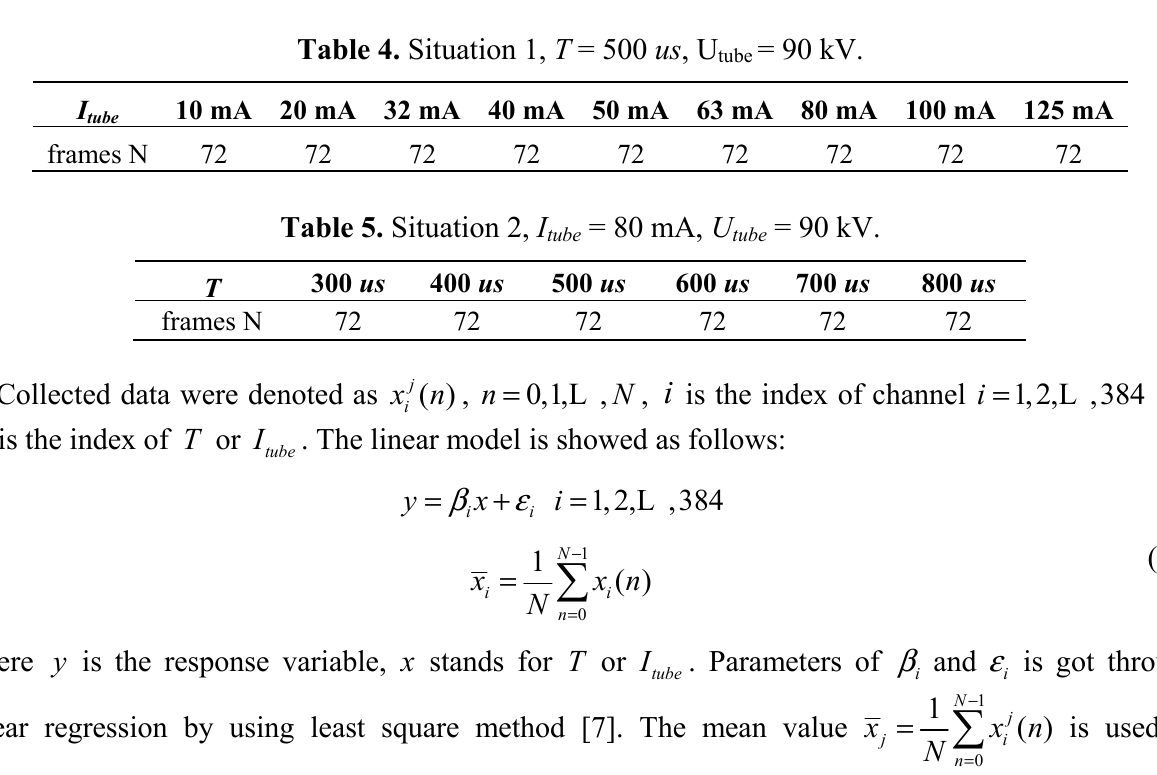
Table 4. Situation 1, T = 500 us , U